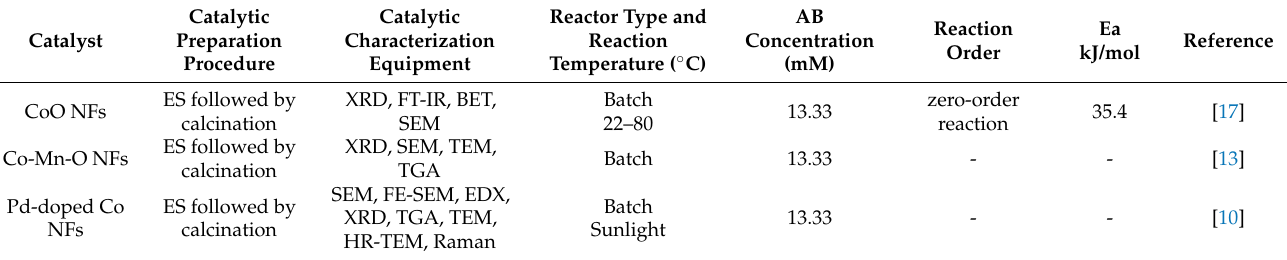
Table 5. Catalytic data of Co NFs for AB